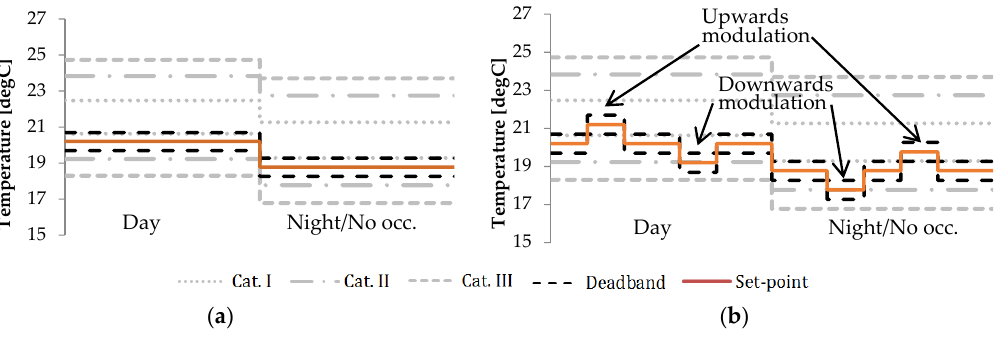
Figure 3. Limits of the comfort categories and room set-point profiles for ( a ) reference case; ( b ) modulated case.